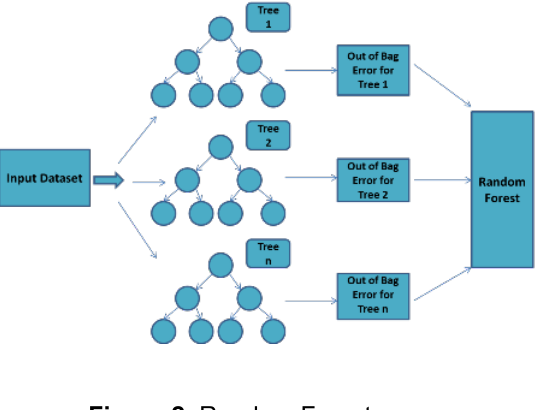
Figure 2 . Random